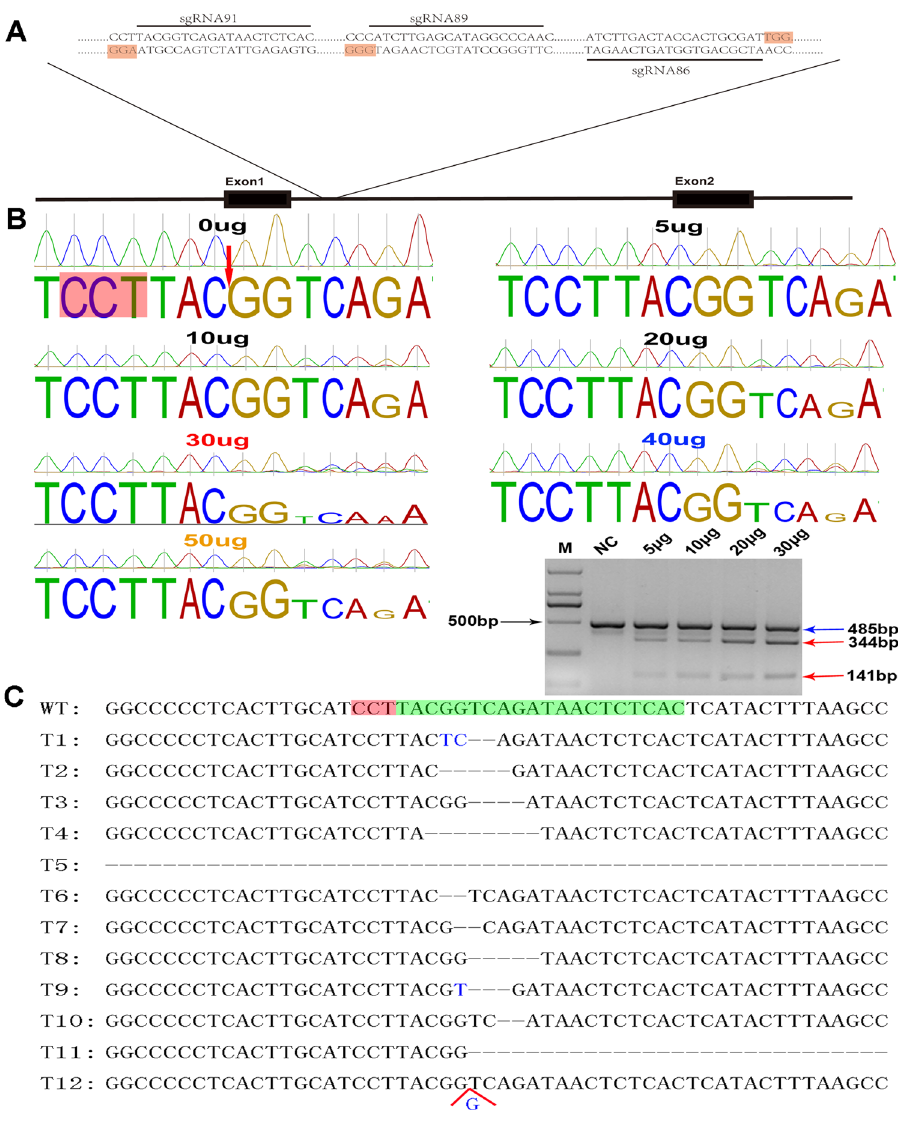
Figure 2. Optimization of the mutation/cutting efficiency at the pROSA26 locus in PFFs. ( A ) Scheme for site- specific targeting/cutting of the pROSA26 locus on chromosome 13 by CRISPR/Cas9. ( B ) Chromatograms of the PCR amplicons for each CRISPR/Cas9 dose group (0 μ g, 5 μ g, 10 μ g, 20 μ g, 30 μ g, 40 μ g and 50 μ g). The red arrow indicates the cleavage site, and the PAM is underlined in red. The mutation efficiency for each CRISPR/ Cas9 dose (5 µ g, 10 µ g, 20 μ g and 30 µ g) was determined by using the T7E1 cleavage assay. M: 100 bp DNA ladder. NC: Negative control, transfection dose of CRISPR/Cas9 was 0 µ g. The blue arrows indicated wild type bands and the red arrows indicated cleaved amplicons. ( C ) The TA cloning and sanger sequences were analysed for indels. The wild-type sequence is located on the first line (WT), and the mutated sequences from the TA cloning are arranged below (T1~T12). The target site is indicated in green; the PAM is indicated in